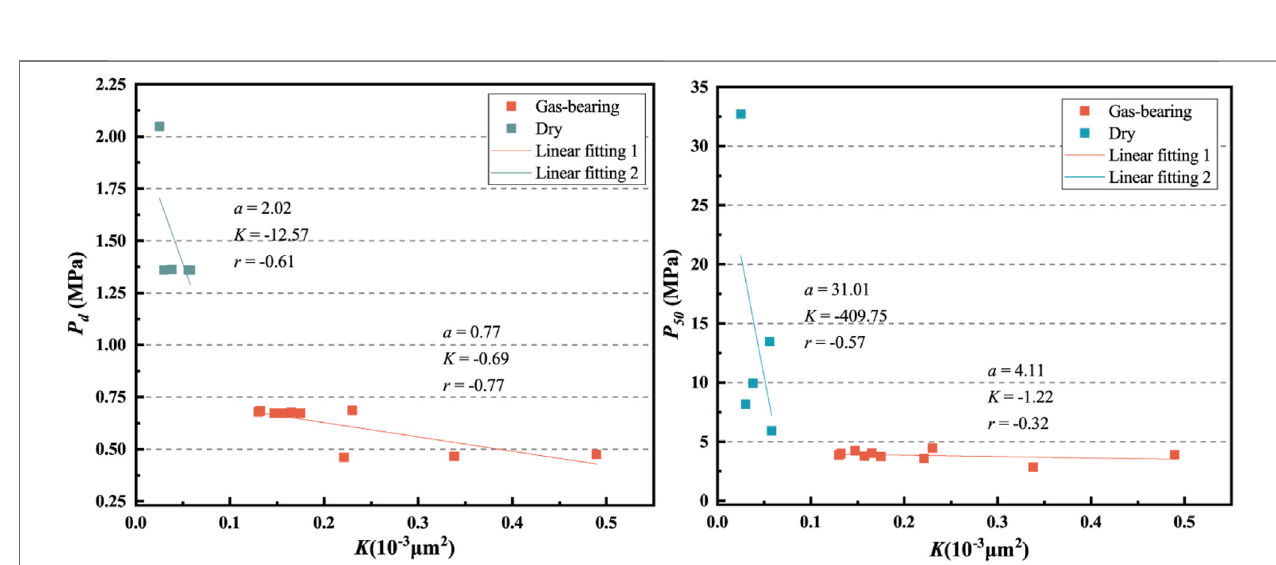
FIGURE 12 | Comparison of gas-bearing status on the correlation between permeability (left) , and P d , P 50 .